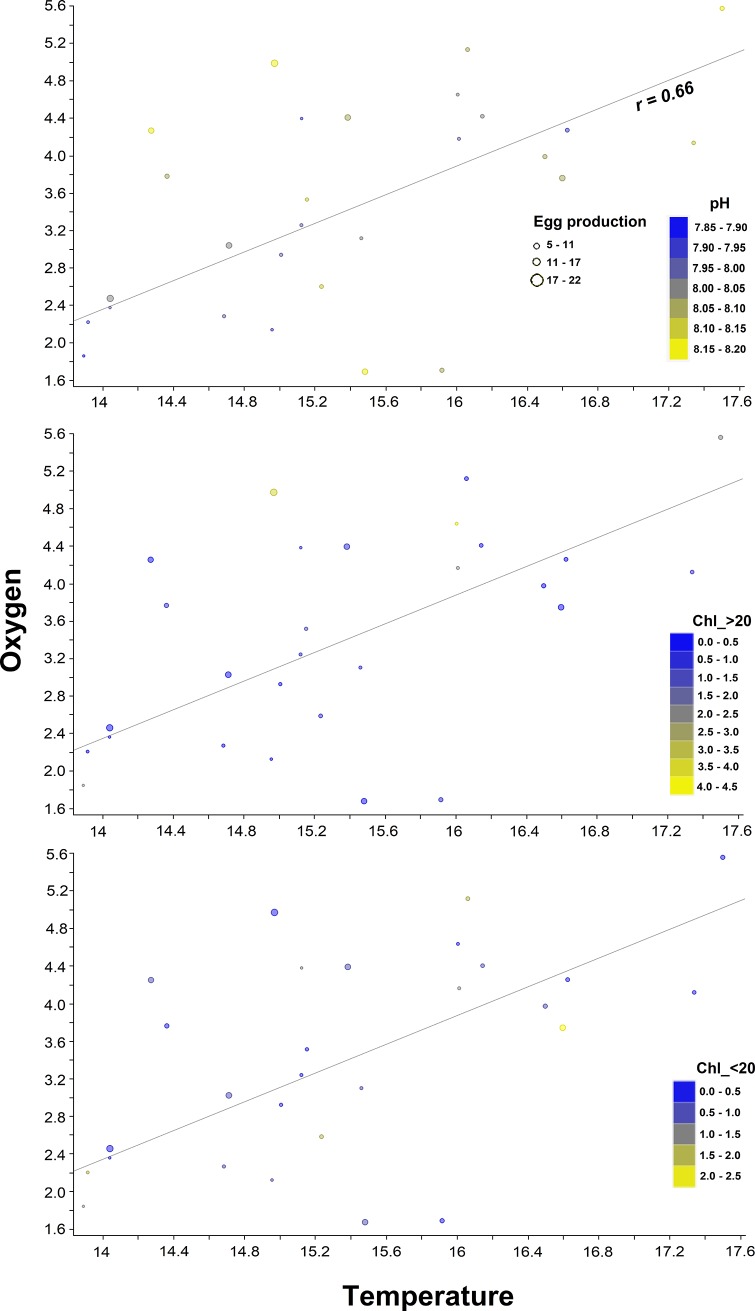
Upwelling modulates copepods reproduction through pH and food variations.(A) Linear (LDA) four-dimensional egg production (EP) ordination as a combined function of temperature, oxygen, pH and Chl. Note how the succession between large (B) and small-sized (C) phytoplankton fractions sustains EP (larger bubbles) despite low temperature, oxygen and pH values.